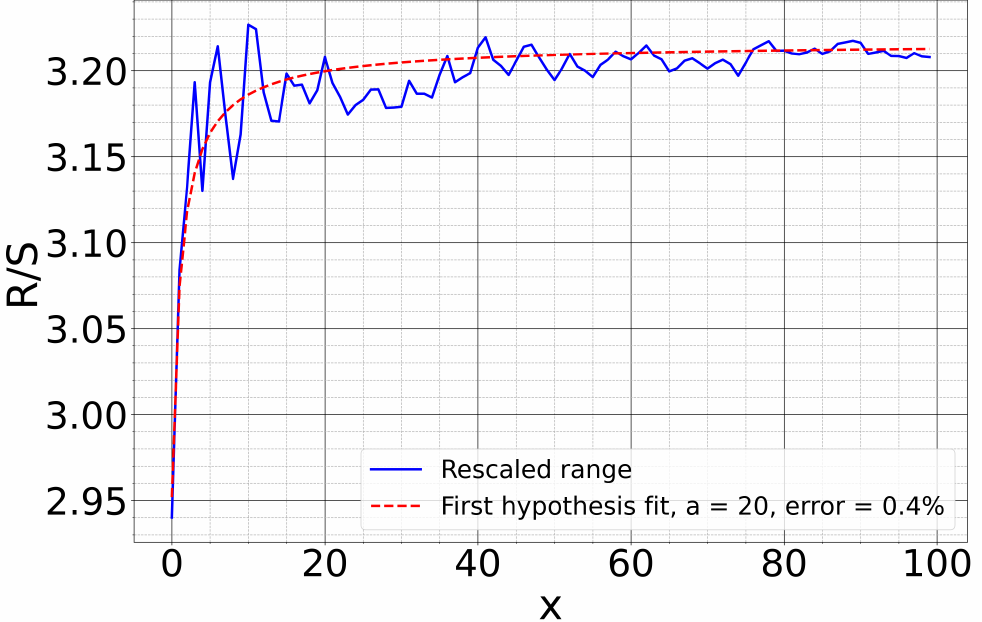
Figure 1. Rescaled range fitting of Adalm Pluto SDR noise phase R/S (Hypothesis 1).